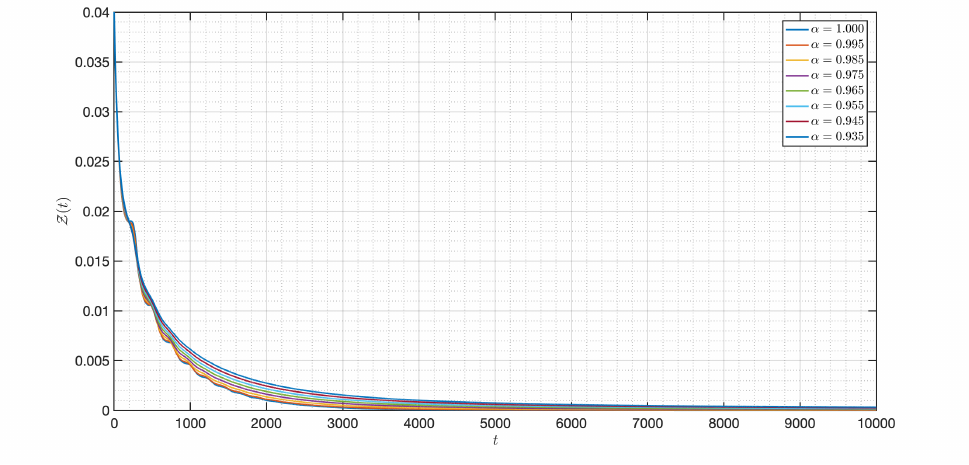
Figure 5. Dynamic of Z ( t ) of the model (3) for different order α in Case I .